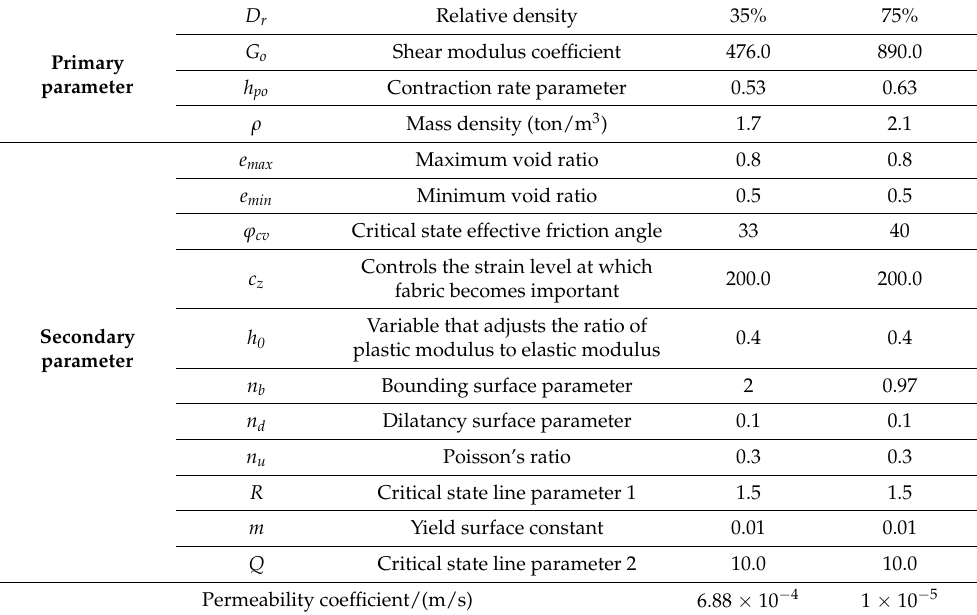
Table 1. PM4S and input parameters of the loose and dense sand layers.